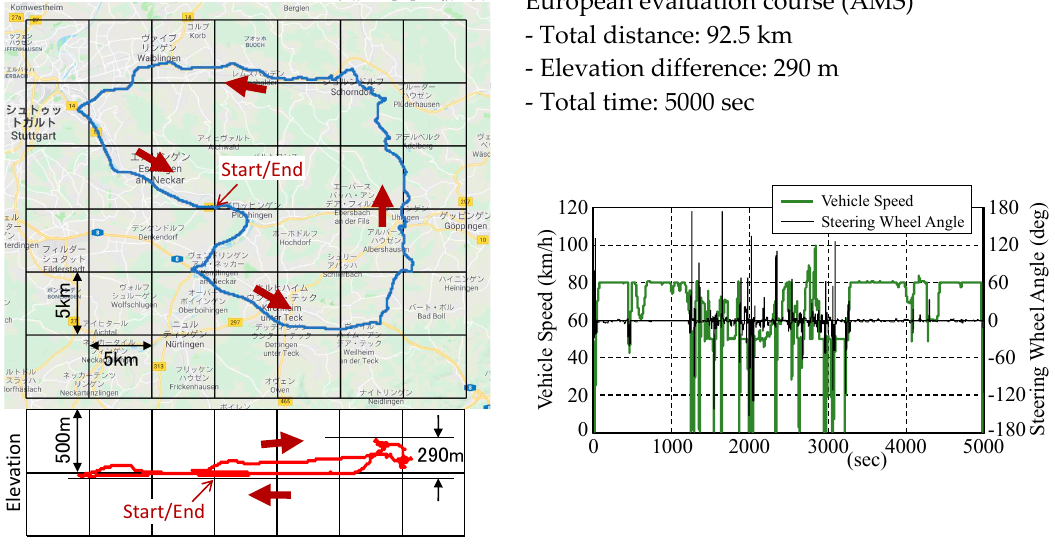
Figure 35. AMS evaluation course as typical European driving route.